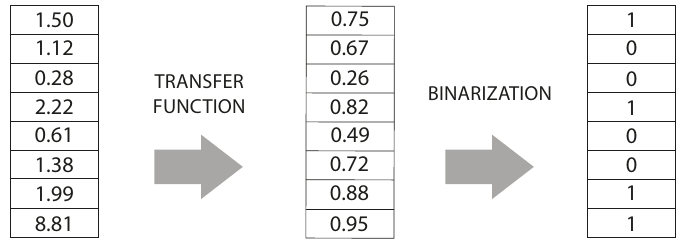
Figure 1. Example of classic Binarization Scheme.